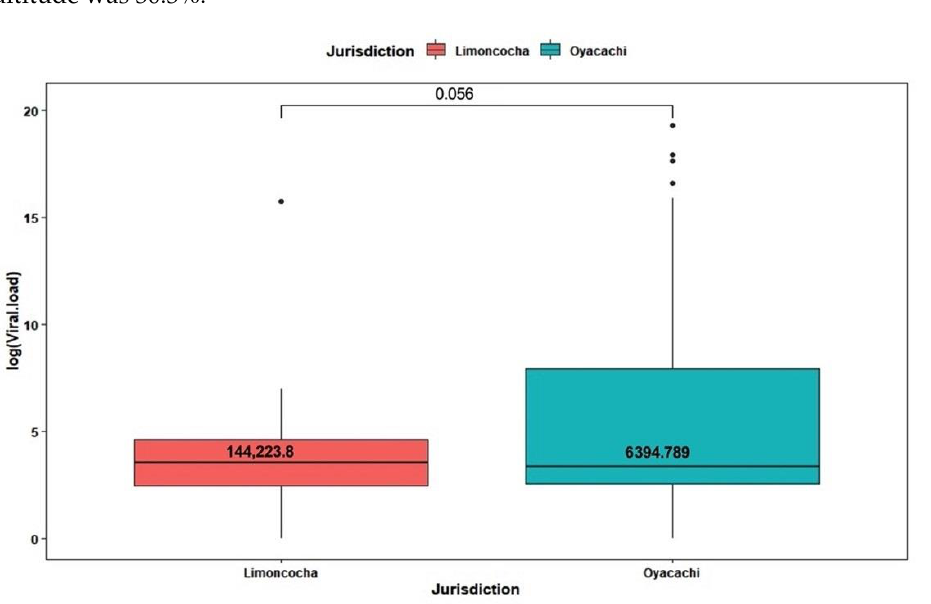
Figure 2. Box plot of viral load composition across jurisdiction (communities) of SARS-CoV-2 test positivity among 108 tested people, 50 from Limoncocha and 58 from Oyacachi. positivity among 108 tested people, 50 from Limoncocha and 58 from